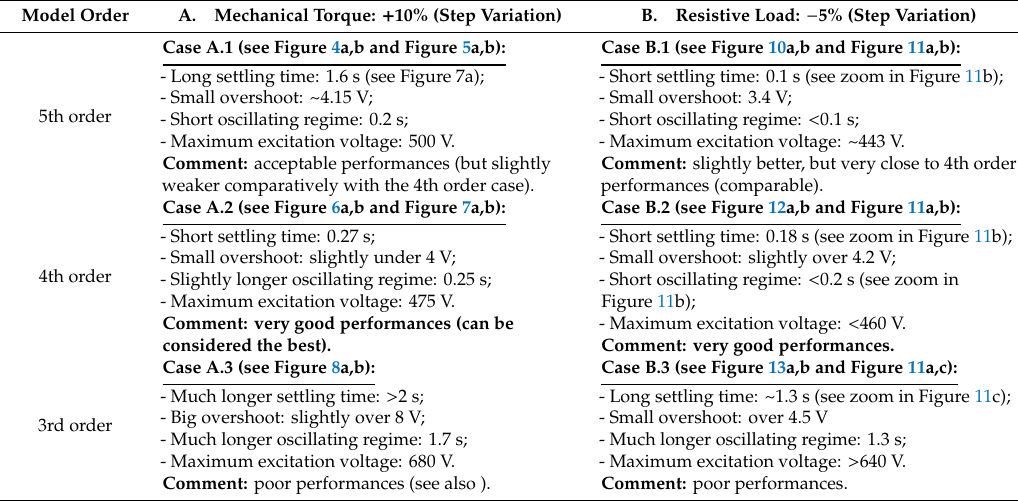
Table 1. Summary of the case